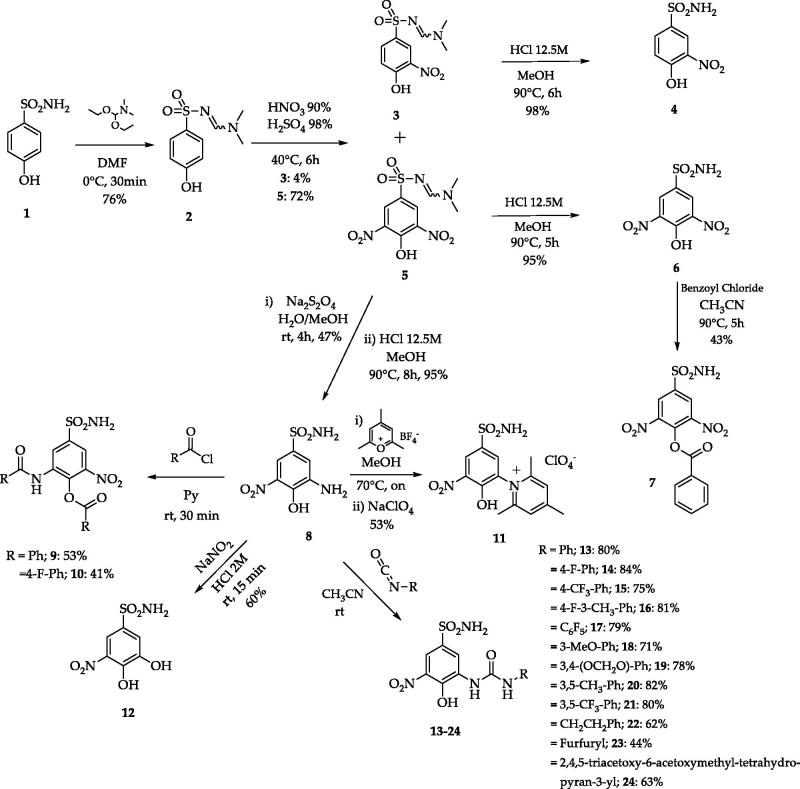
Synthetic routes to 3-nitrobenzenesulfonamides 3–2421.